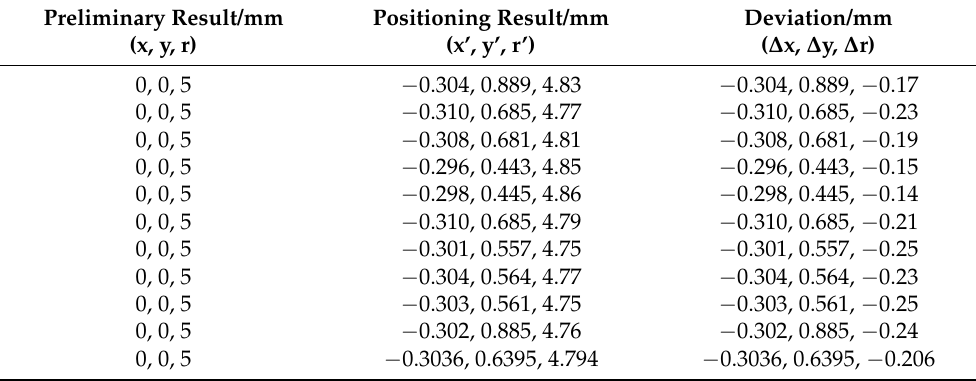
Table 2. This table shows the creel positioning data at 190 mm